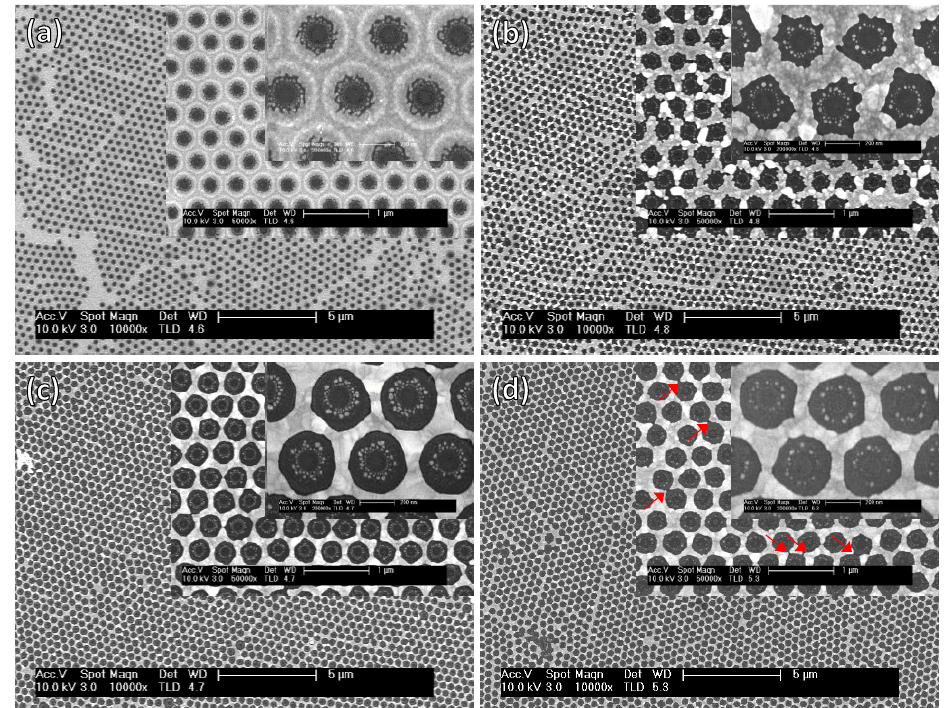
Figure 3. FESEM images at different magnifications of the surface structure of the Au film as deposited through the colloidal mask on Si ( a ), after KI immersion for 1 min ( b ), after annealing at 300 °C ( c ), and after both annealing and KI etching ( d ).